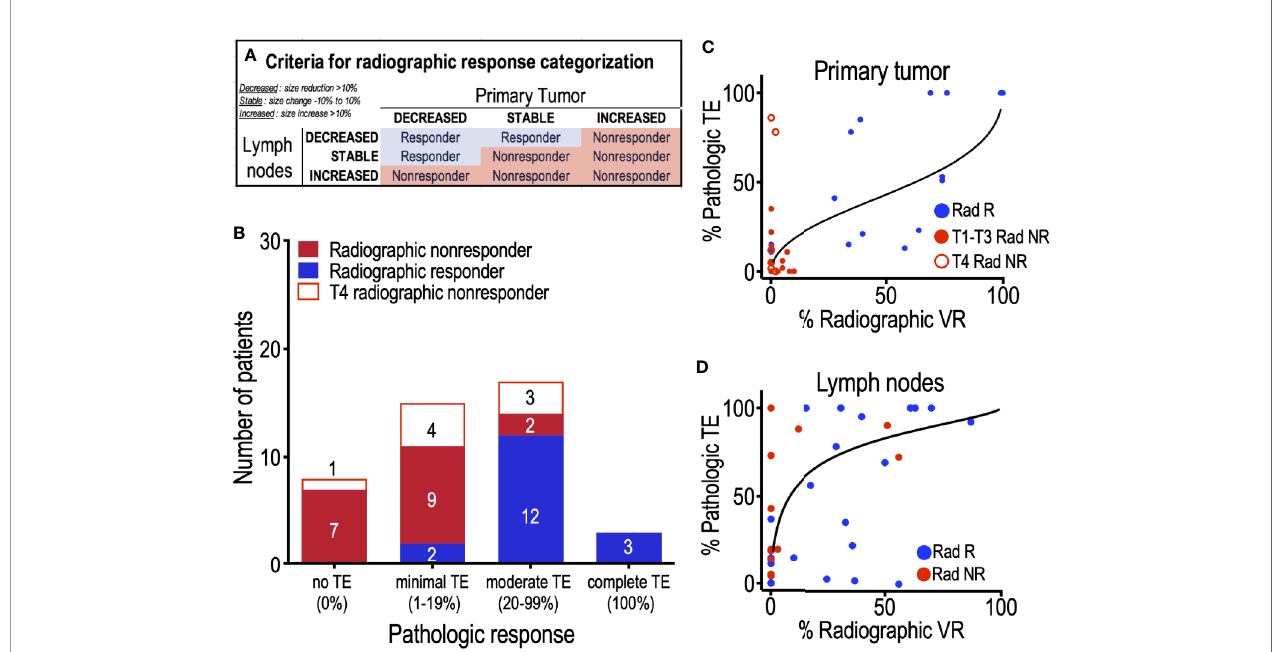
FIGURE 4 | Correlation of radiographic volumetric response and pathologic treatment effect. (A) Assignment of patients to radiographic volumetric response groups, based on the percent change in volume of both the primary tumor and the combined volume of all abnormal lymph nodes. (B) All 8 patients with T4 primary tumors (red outlines) were characterized as radiographic non-responders. 18 patients with T1 – T3 primary sites were designated radiographic non-responders (solid red); 89% (16/18) exhibited no pathologic treatment effect ( n = 7) or minimal PTE ( n = 9). Of the 17 patients designated radiographic responders (blue), 15 (88%) demonstrated moderate ( n = 12) or complete ( n = 3) treatment effect. (C) Quantitative analysis of primary sites demonstrates a strong positive correlation between RVR and pathologic TE (slope = 0.55, p < 0.001) of individual tumors, despite the failure of T4 primary tumors (red outlined circles) to demonstrate any RVR. (D) Analysis of abnormal nodes demonstrates a signi fi cant correlation (slope = 0.65, p < 0.05). For (D) , each data point represents a single